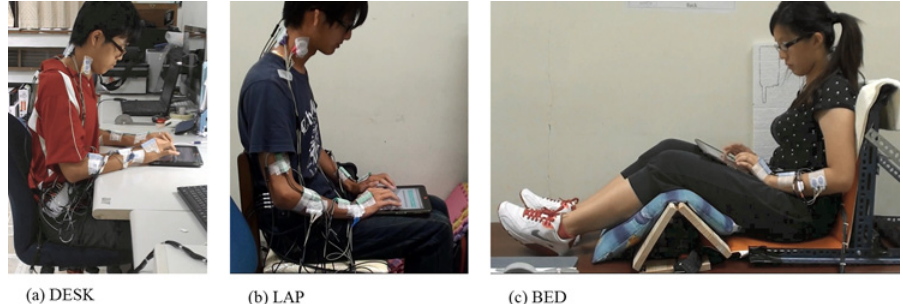
Fig 1. The three positions of tablet usage evaluated. (a) DESK position, participants seated on an adjusted chair with the tablet on the desk. (b) LAP position, participants seated on an adjusted chair with the tablet on the laps. (c) BED position, participants seated on a bed with knees bent and the tablet on the thighs.